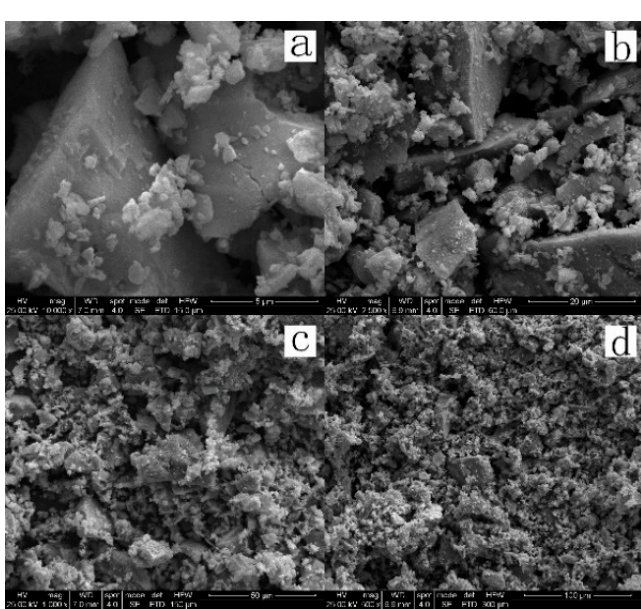
Figure 2. Morphologies of the ZnS concentrate. Scale: ( a ) 5 μ m; ( b ) 20 μ m; ( c ) 50 μ m; ( d ) 100 μ m. Table 1. Chemical composition of the ZnS concentrate.